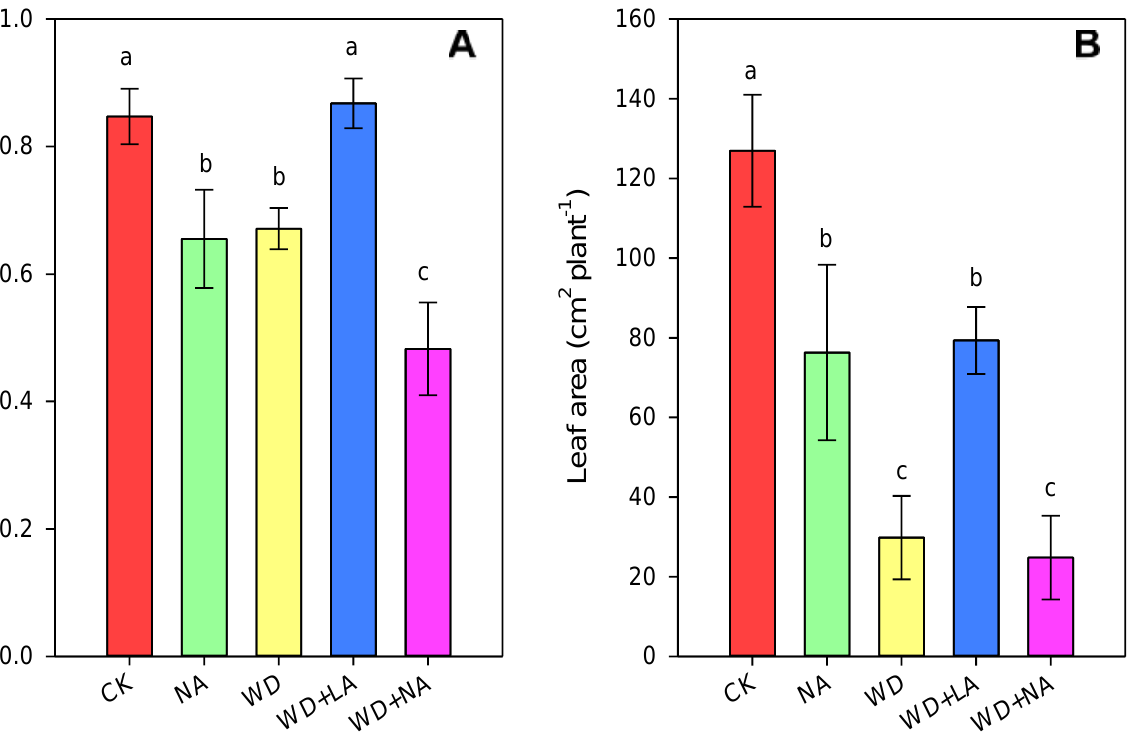
Figure 2. Leaf relative water content ( A ) and leaf area ( B ) of maize seedlings supplemented with L-arginine under drought stress conditions. CK: control treatment; NA: 25 µ mol L − 1 of L-NAME; WD: 20% PEG; WD + LA: 20% PEG + 150 µ mol L − 1 of L-arginine; WD + NA: 20% PEG + 25 µ mol L − 1 of L-NAME. The results are presented as the means ± standard error ( n = 3). Significant differences are represented by lowercase letters ( p ≤ 0.05) based on the LSD test. Lowercase letters above the error bars in ( A , B ) indicate significant differences among the five treatments ( p < 0.05). L-NAME, N γ -nitro-L-arginine methyl ester; LSD, least significance difference; PEG, polyethylene glycol.